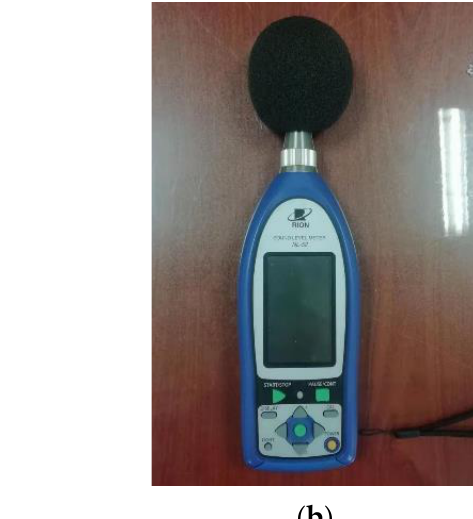
Figure 4. Real images of the test rig and the sound level meter. ( a ) Test rig. ( b ) Sound level